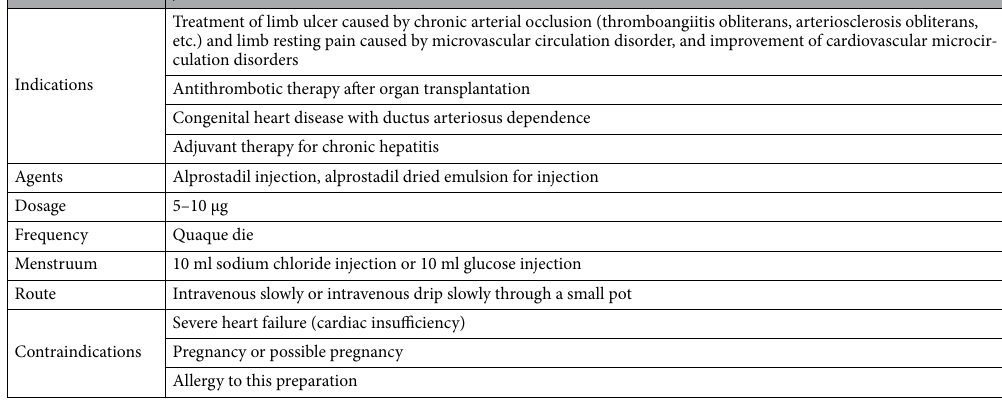
Table 1. Internal guideline for the rationality of Lipo-PGE 1 use in the Affiliated Hospital of Southwest Medical